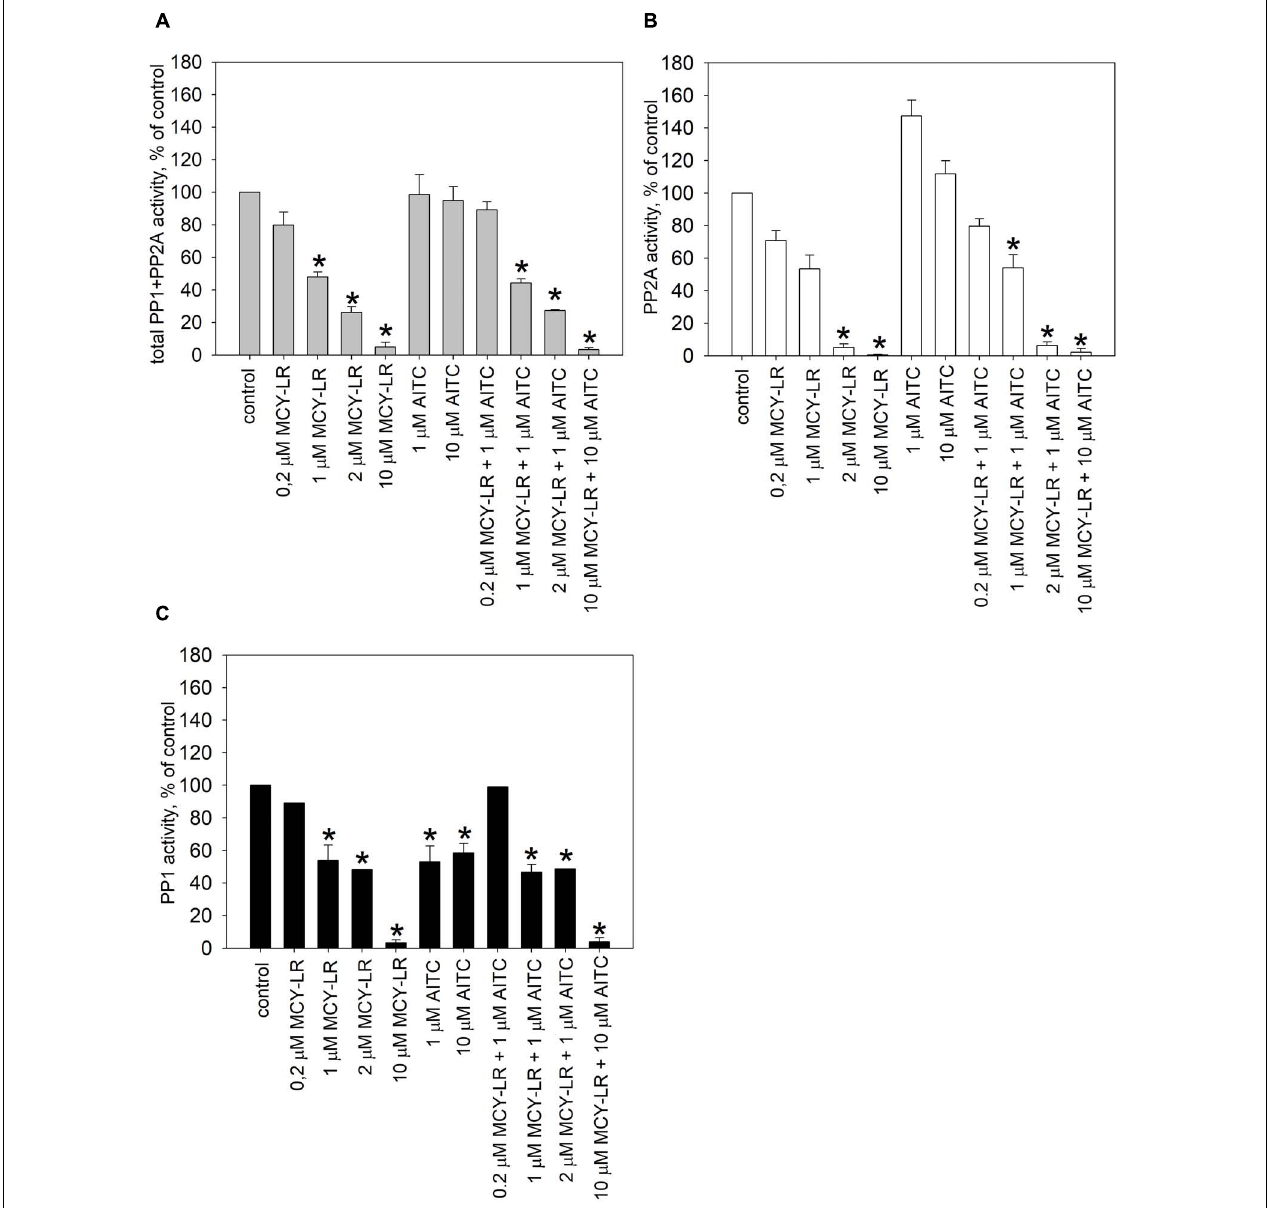
FIGURE 5 | Effects of AITC and MCY-LR on total protein phosphatase (PP1+PP2A) (A) , PP2A (B) , and PP1 (C) activities of V. faba whole lateral roots in vivo . ∗ Significant differences of treatments to controls ( P < 0.05), n ≥